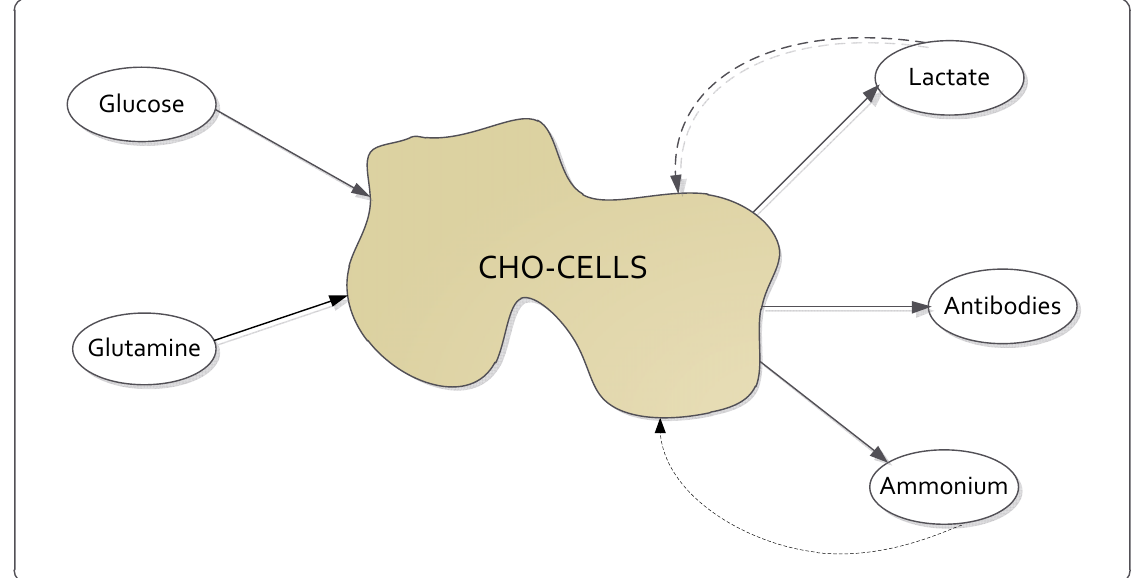
Figure 23: The main metabolism of